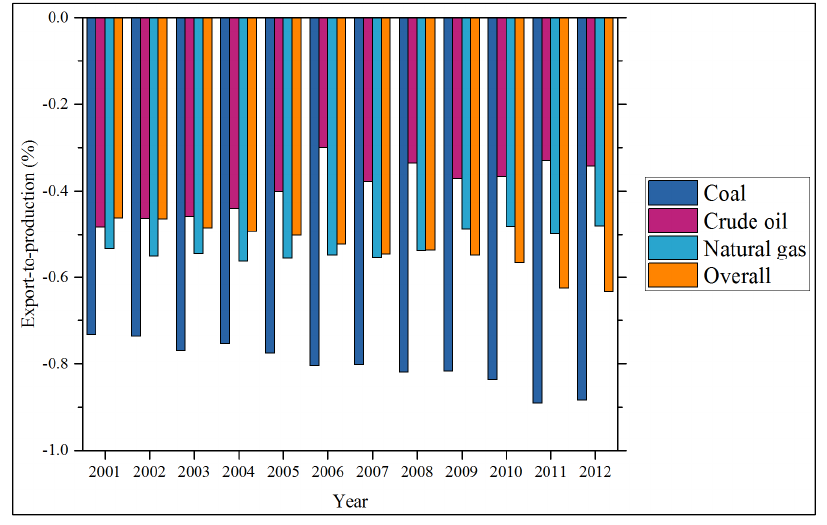
Figure 37. Indonesia: export to